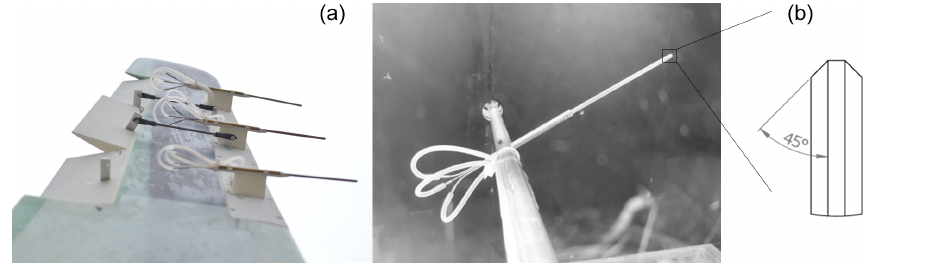
from 16 to 22 m s − 1 with steps of (cid:49)U = 2 m s − 1 . The